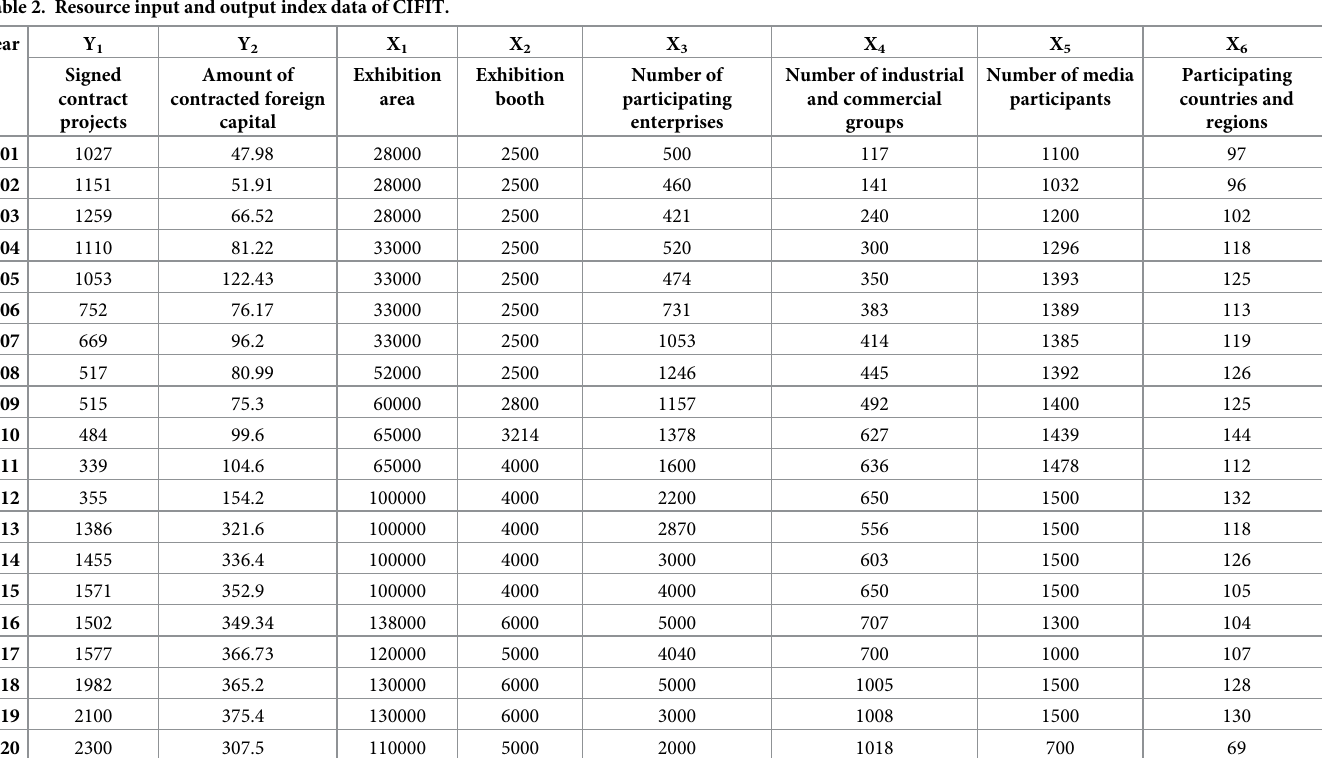
Table 2. Resource input and output index data of